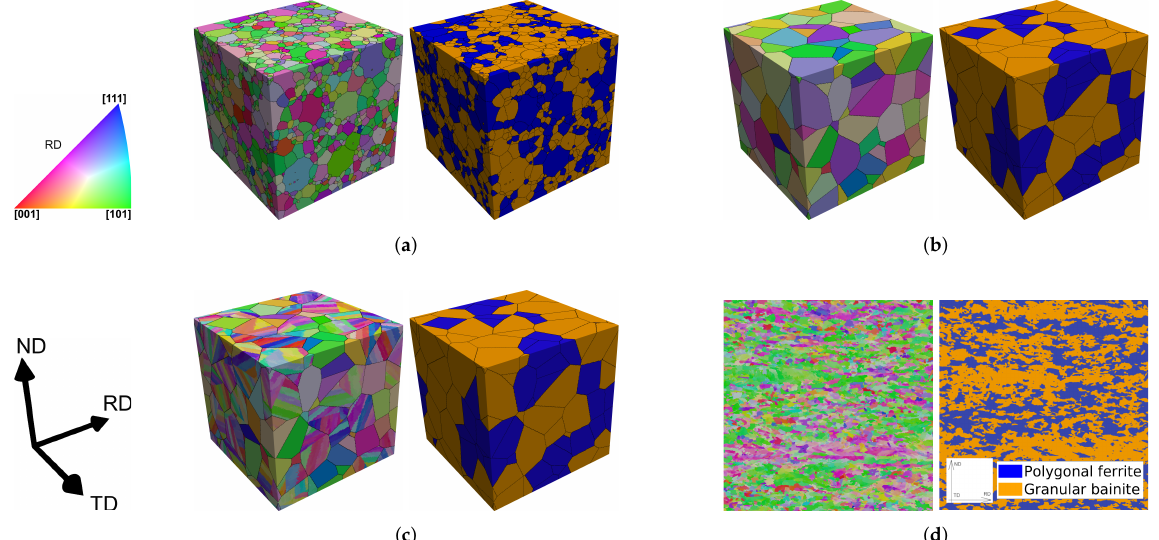
Figure 4. 3D-RVE ( a ), 3D-RVE no-substructure ( b ), 3D-RVE gb-substructure ( c ), and 2D-RVE mea- sured ( d ) for material S 2 . IPFs along the RD (horizontal direction in the 2D-RVE) are displayed in the left. Phase maps are shown in the right, where blue corresponds to polygonal ferrite and orange corresponds to granular